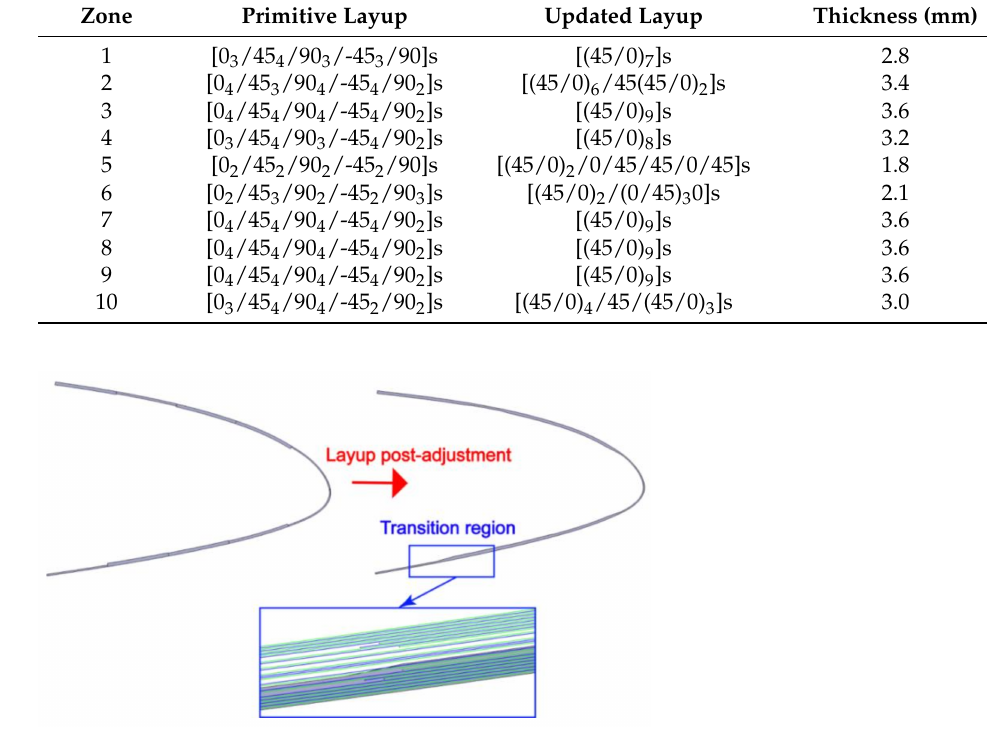
Figure 12. Engineering adjustment of the variable-thickness laminate including transition region.